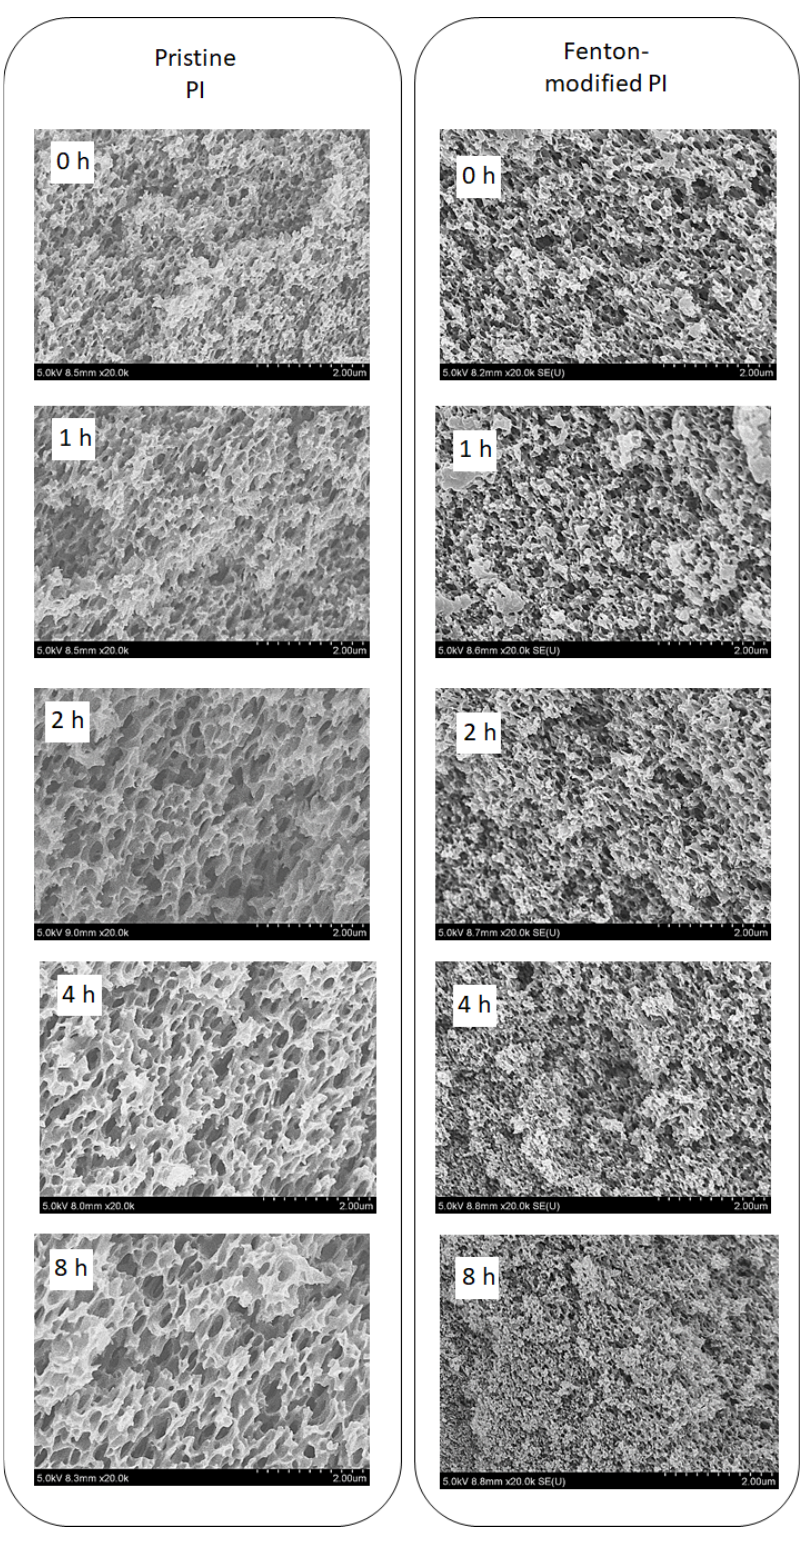
Figure 6. SEM images of pristine and Fenton-modified PI membranes after exposure to 50 w / v % H 2 SO 4 for 0, 1, 2, 4, and 8 h.